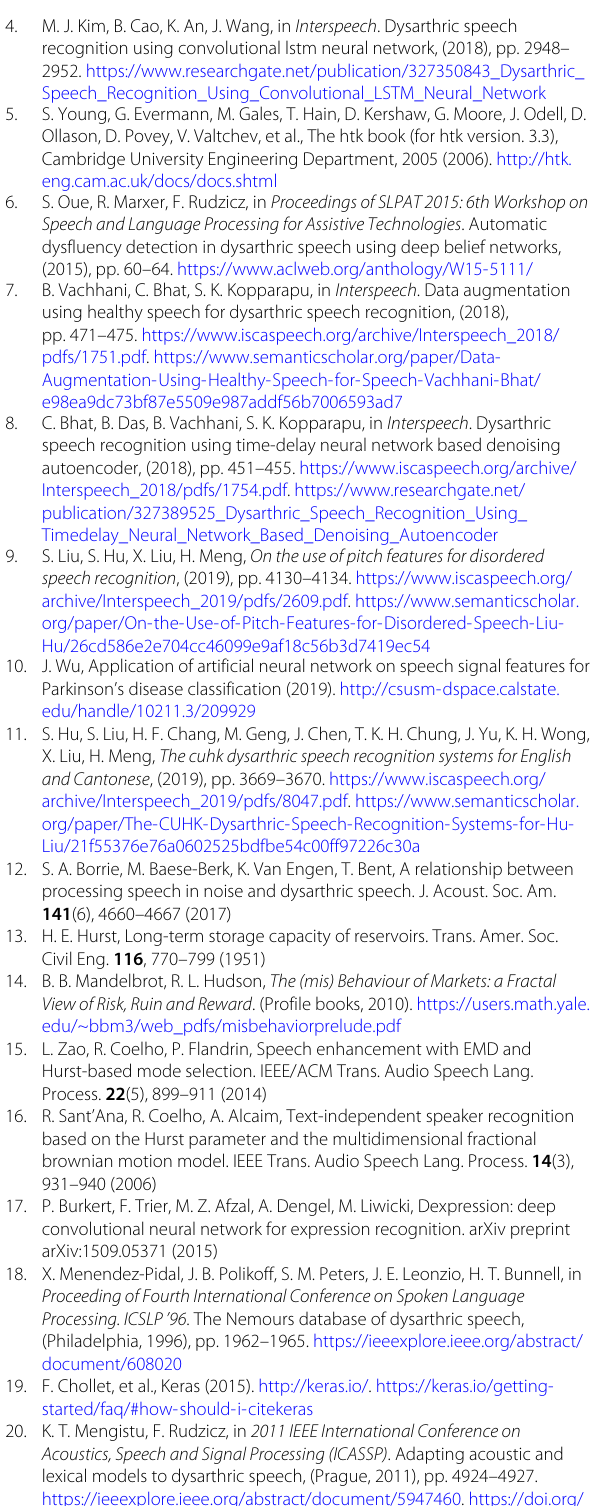
Table 3 Global accuracies of the HMM-GMM-, CNN-,